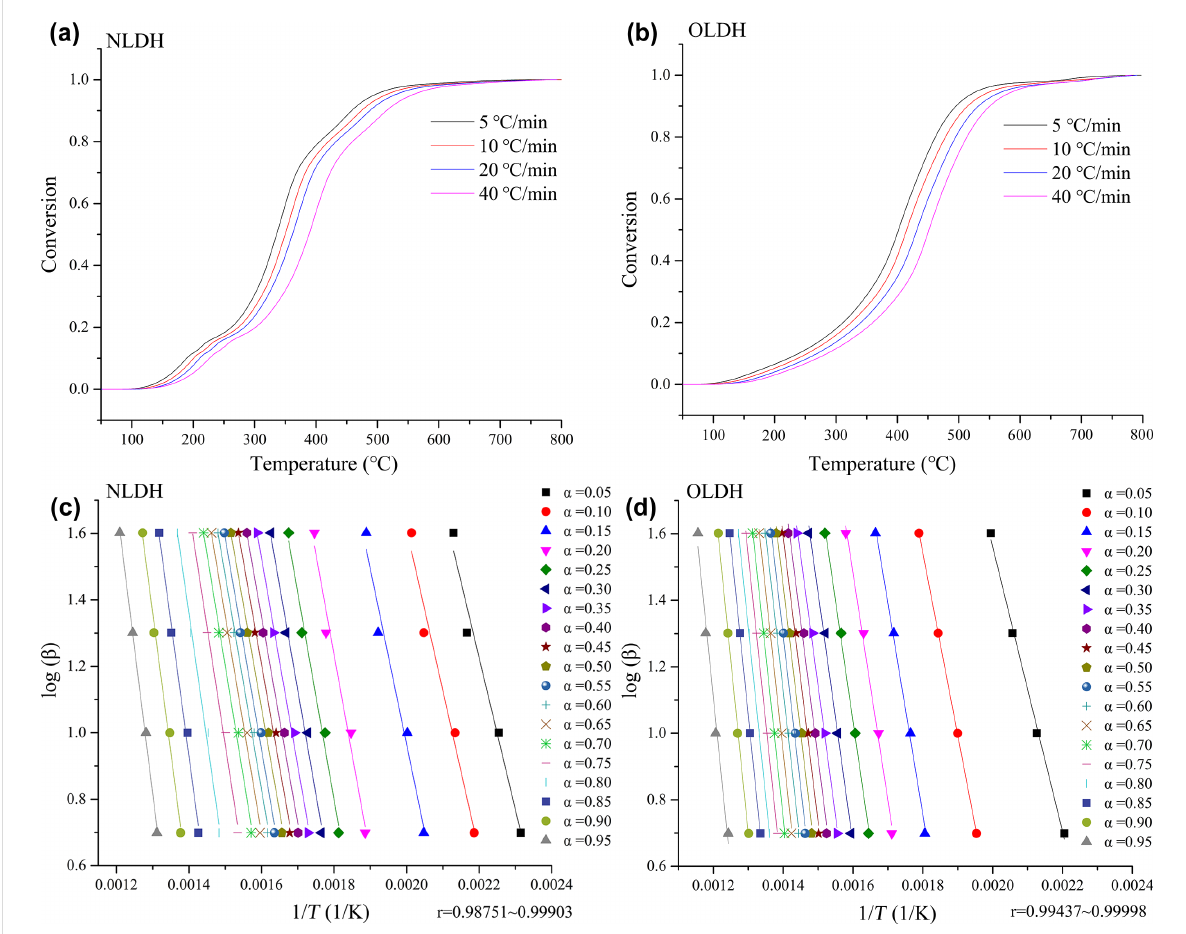
Figure 11: (a, b) Typical conversion curves at different heating rates and (c, d) plots of log( β ) as a function of 1/ T at different values of α .